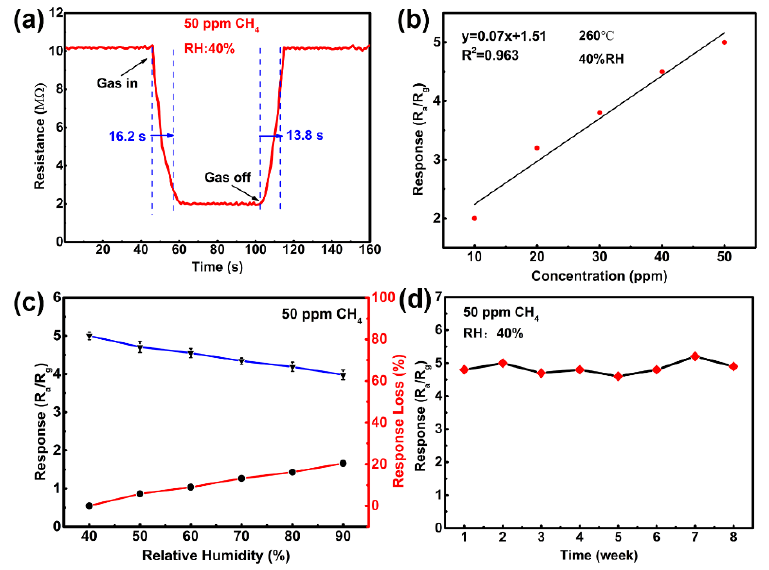
Figure 12. ( a ). Response and recovery curve of Pd Cs-2/ZnO 1−x sensor (50 ppm CH 4 at 260 °C, 40% RH); ( b ) The responses to different concentrations of CH 4 (260 °C, 40% RH, 10~50 ppm) as well as their fitting curve; ( c ) The relationship between response and response loss ratio, as well as RH (50 ppm CH 4 at 260 °C); and ( d ) The stability of Pd Cs-2/ZnO 1−x gas sensor to 50 ppm CH 4 within 8 weeks, 40% RH.